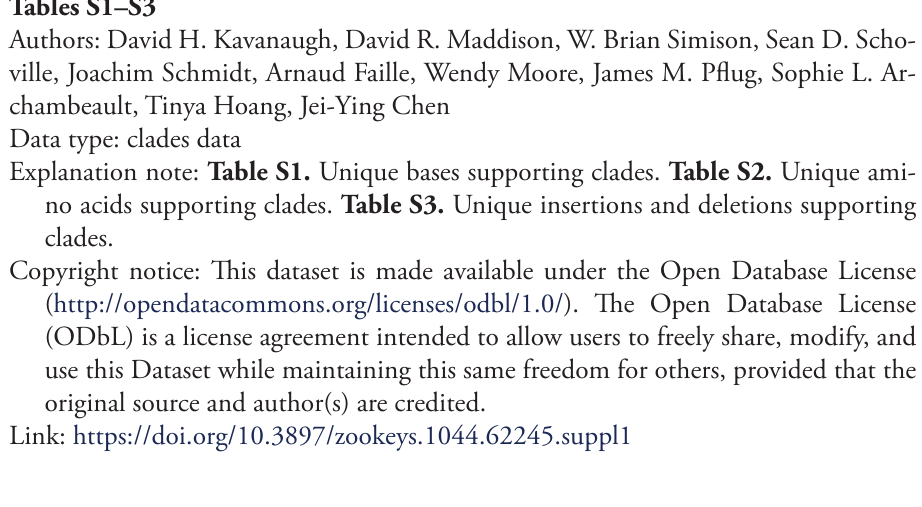
Explanation note: Table S1. Unique bases supporting clades. Table S2. Unique ami- no acids supporting clades. Table S3. Unique insertions and deletions supporting